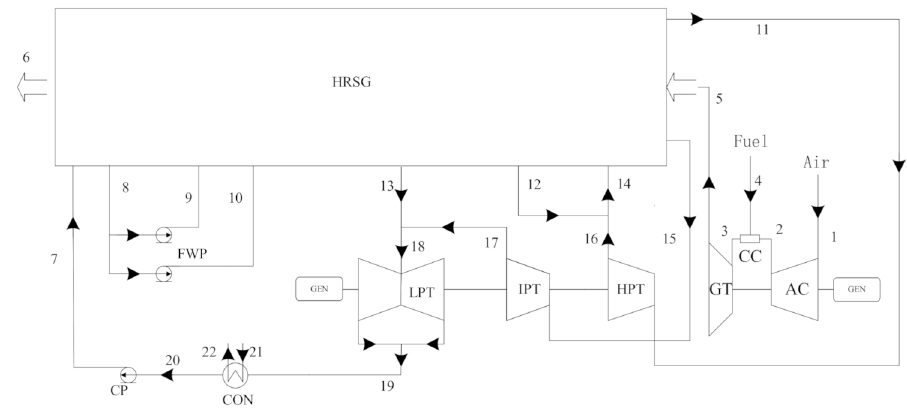
Figure 2. Physical structure of the CCGT system.